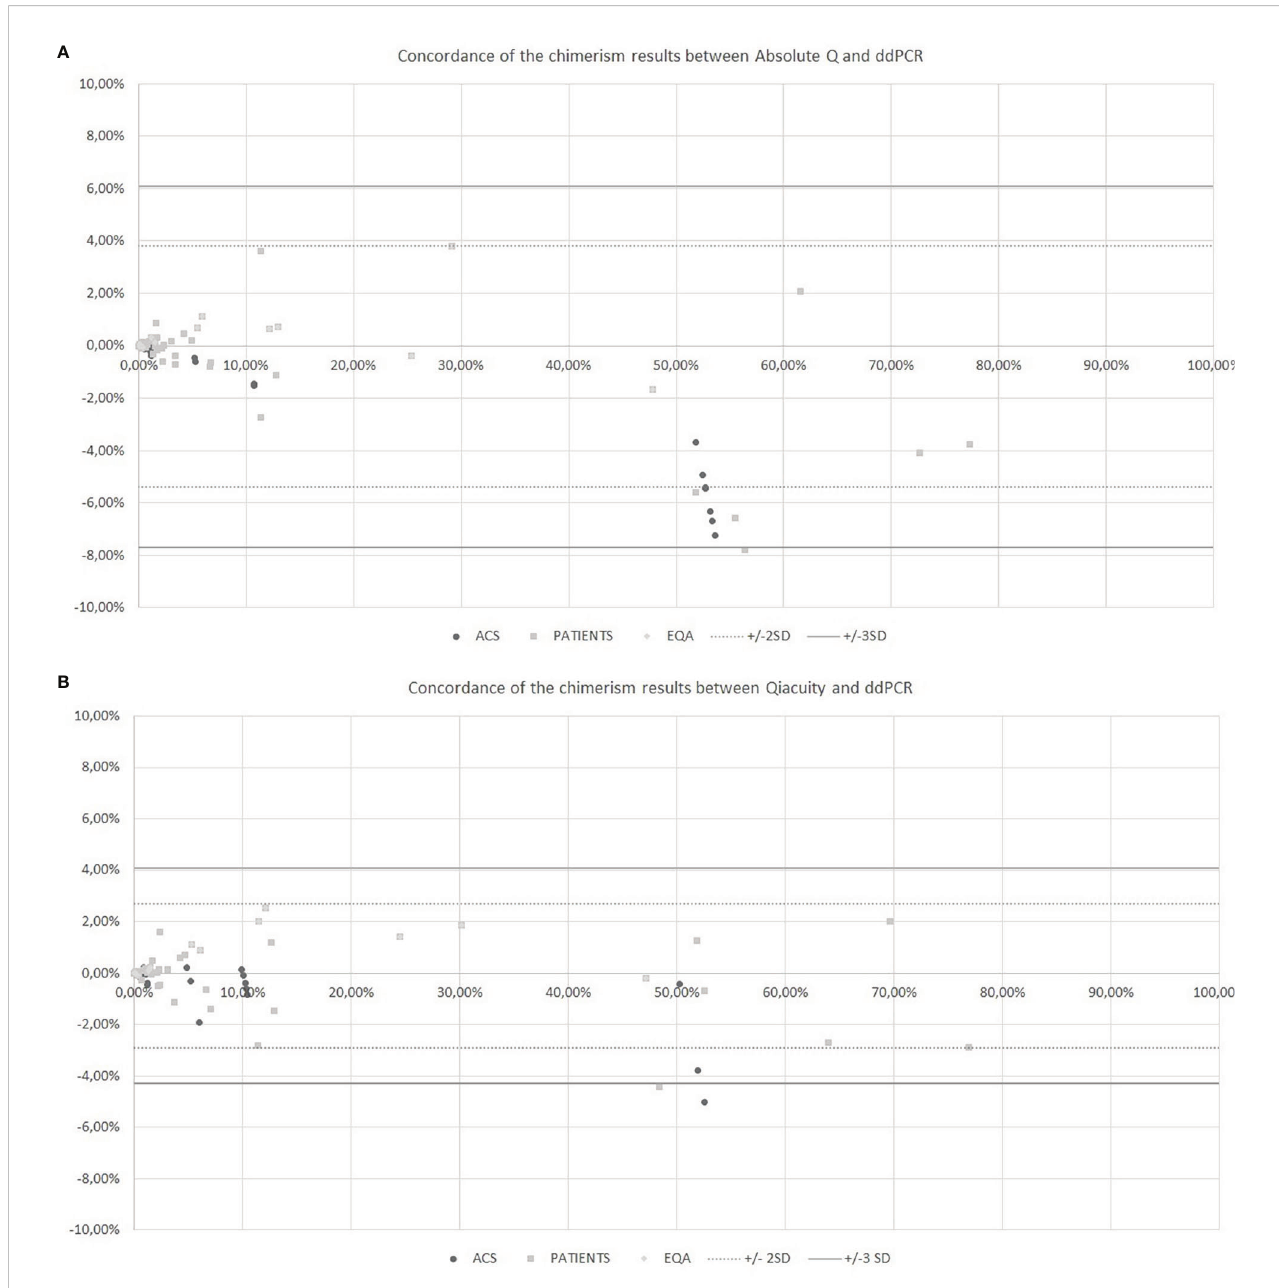
FIGURE 2 Concordance of the chimerism results between Absolute Q and ddPCR (A) and between Qiacuity and ddPCR (B) using the Bland-Altman plot. The Bland-Altmann plot includes the ± 2 standard deviation value (dotted lines) and ±3 standard deviation value (solid lines). ACS. Arti fi cial Chimeric Samples; EQA. External Quality